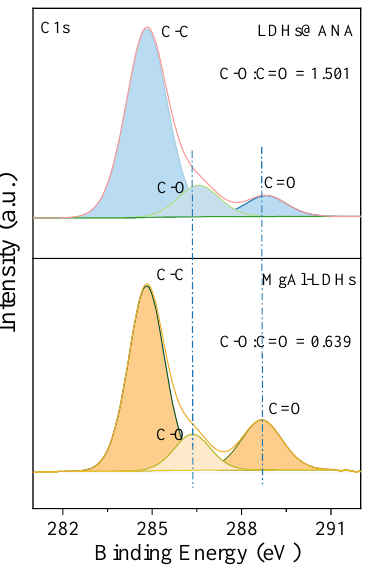
Figure 7. XPS spectra of C1s in MgAl-LDHs and LDHs@ANA.